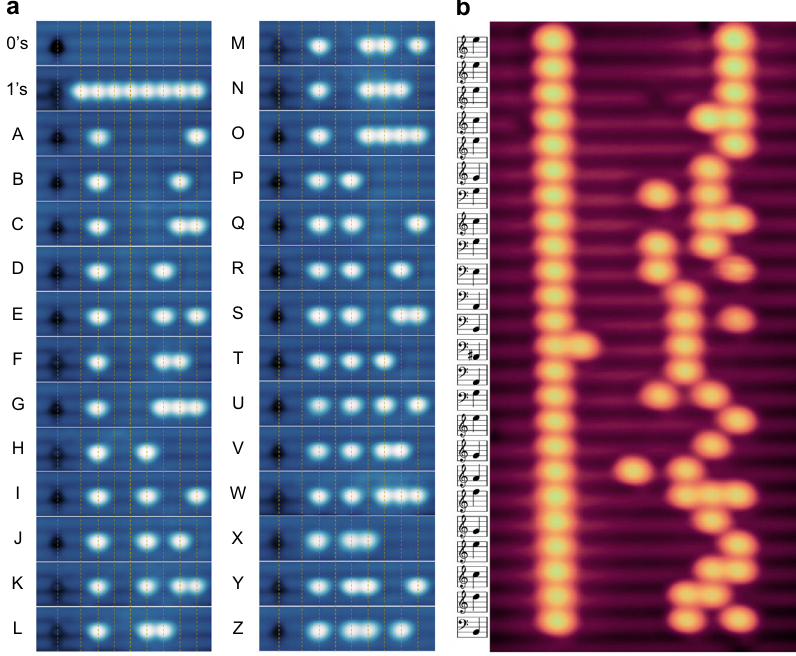
Fig. 4 8-bit and 192-bit atomic rewritable memories. a ( V = − 1.75 V, I = 50 pA, T = 4.5 K, 2.4 × 10 nm 2 ) Scanning tunneling microscope (STM) images of a rewritable 8-bit memory constructed from dangling bonds (DBs). The DBs appear as bright protrusions in the images, the black defect is an area of missing silicon. The letters of the English alphabet were converted to their ASCII binary forms (e.g., A = 01000001) and written to the same area using hydrogen lithography and hydrogen repassivation techniques. An average of three bits could be repassivated sequentially between the letters shown. Scale bar, 3 nm. b ( V = − 1.8 V, I = 50 pA, T = 4.5 K, 21.5 × 10.7 nm 2 ) An STM image of an expanded 192-bit memory, storing 24 simpli fi ed notes (converted into binary) of the popular Mario videogame theme song. The notes consist of 62 DBs, forming the largest error-free DB structure to date. Both memories have a bit density of 1.70 bits per nm 2 and can be read directly from the STM or from a stored image. Scale bar, 4 nm